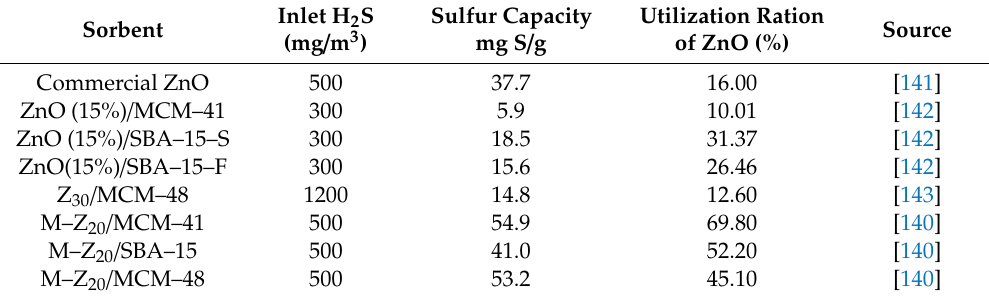
Table 5. Breakthrough sulfur capacity of commercial desulfurizer and molecular sieves supported